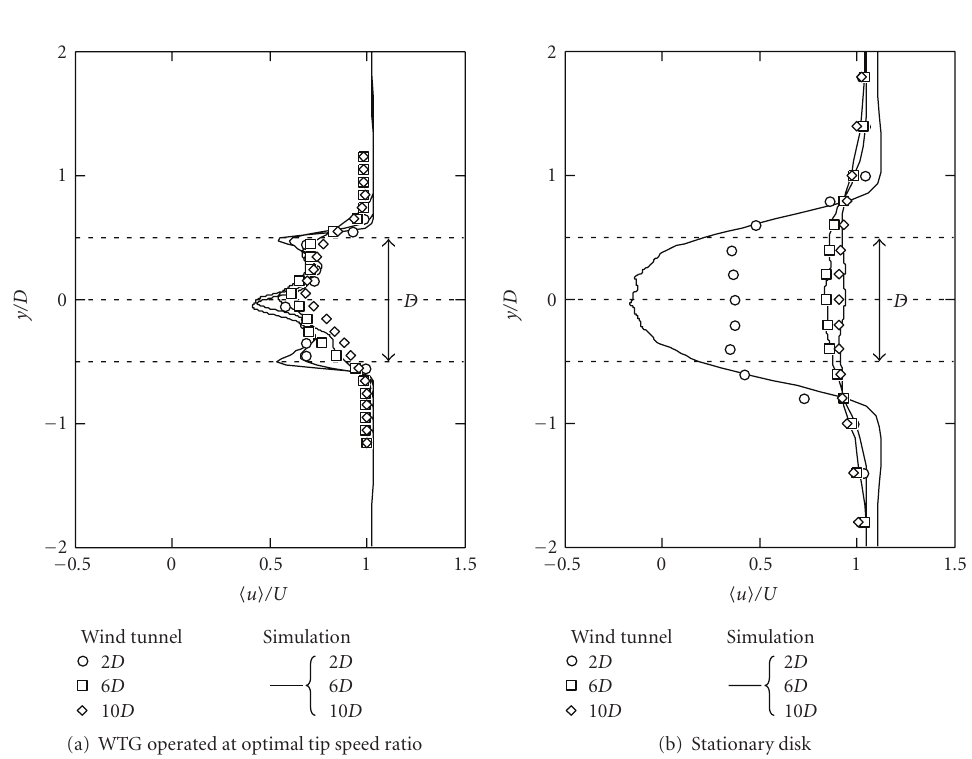
Figure 12: Spanwise profiles of the time-averaged streamwise ( x ) velocity at z = 0 (( x , y , z ) = (0, 0, 0) indicates the center of the rotor; see Figure 3). The profiles are observed at x = 2 D ( (cid:7) ), 6 D ( the spanwise position on the y -axis are normalized by the uniform inflow velocity, U , and D , respectively. The y -coordinate of the rotor is shown with